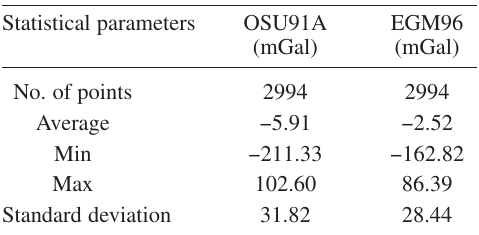
Table I. Statistical parameters for the gravity residual ( ∆ g r ) computed using EGM96 and using OSU91A. Statistical parameters